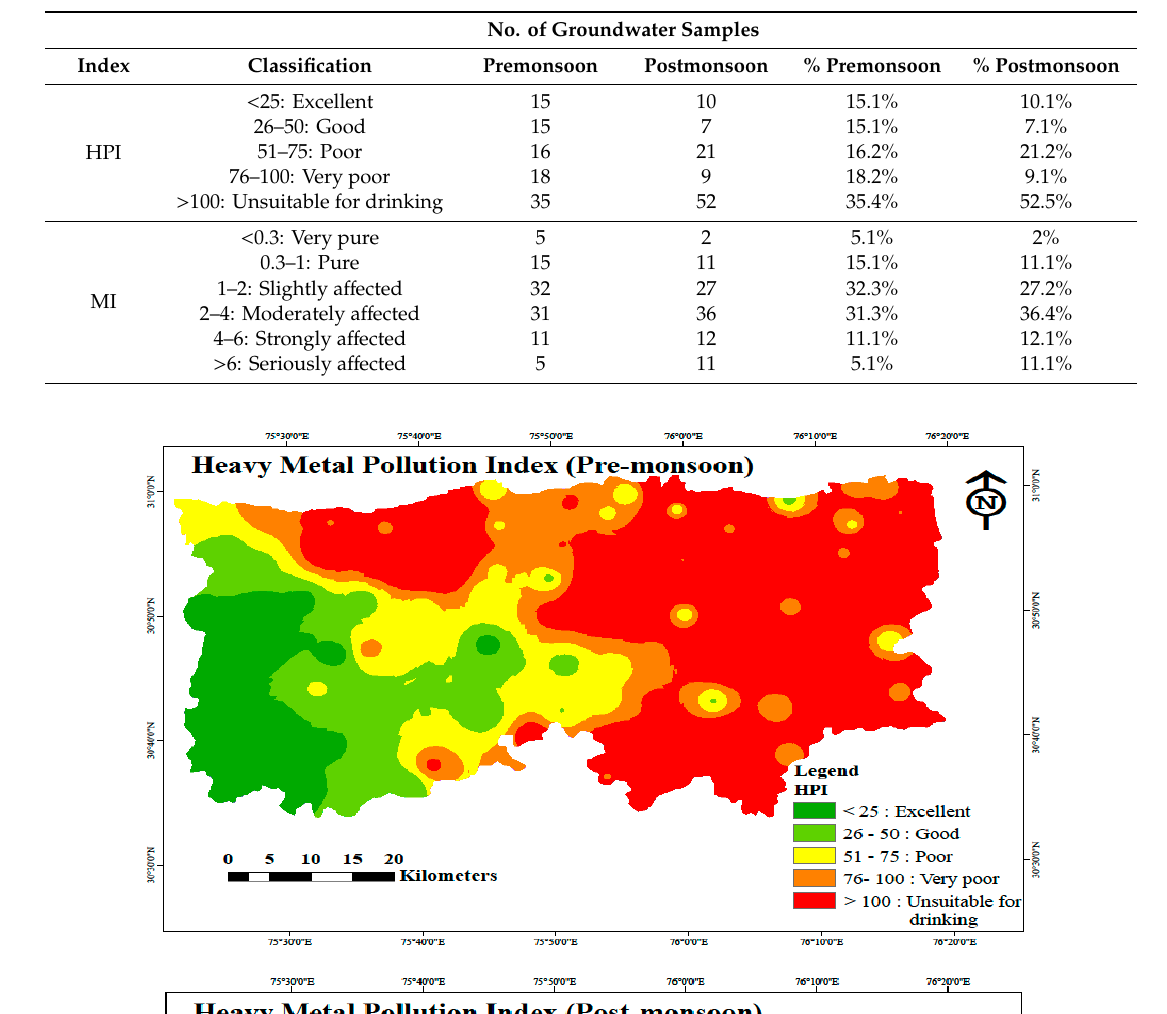
Table 4. Classification based on the heavy metal pollution index (HPI) and the metal index (MI).